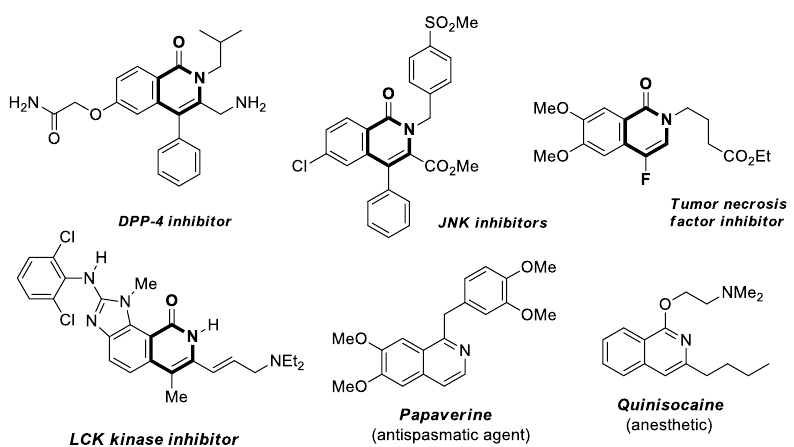
Figure 1. Selected bioactive isoquinolones and isoquinolines.